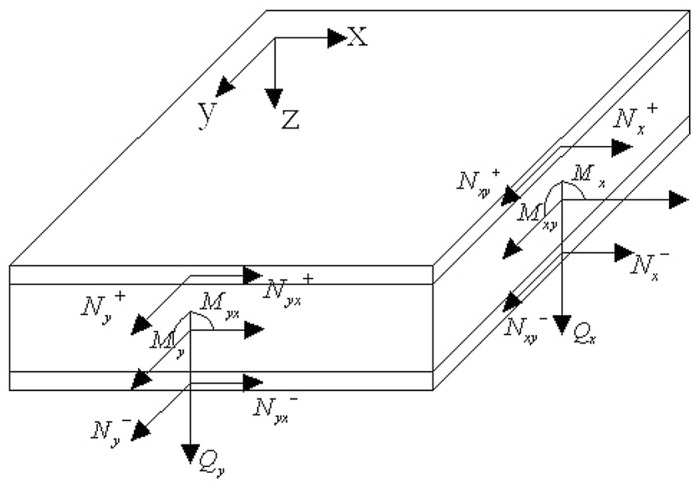
Mechanical model of the simulated sandwich panel.